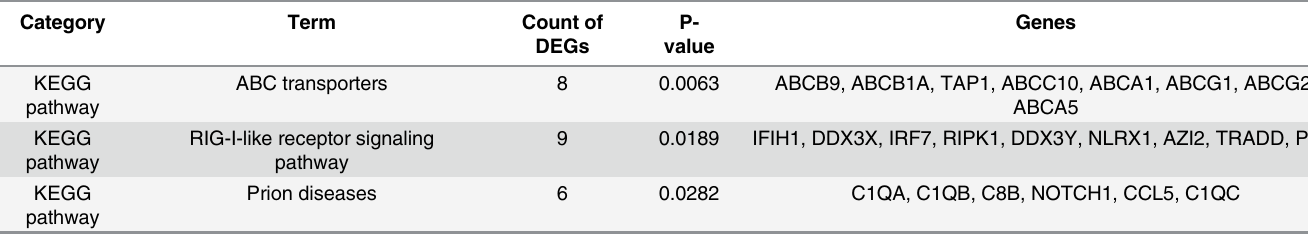
Table 1. Gene ontology (GO) analysis of microarray in